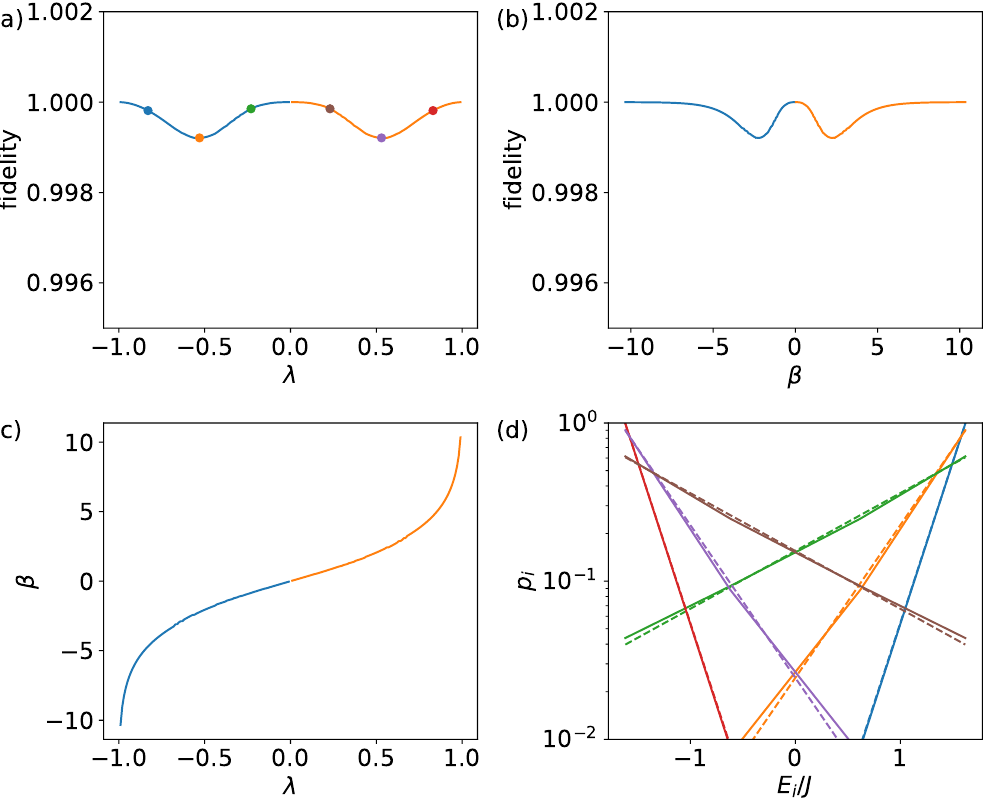
Figure 2: The fidelity between the steady state and the corresponding thermal state as a function of (a) the free parameter λ and (b) the inverse temperature β . The inverse temperature of the thermal state is fixed by optimizing the fidelity and is shown in (c). (d) compares the distribution of the steady state (solid lines) and the corresponding thermal state (dashed lines) on the eigenbasis of the system at various λ [ marked by circles in (a) ] . The parameters are M = 4, N = 1, U = 0, and γ = 0.001 J